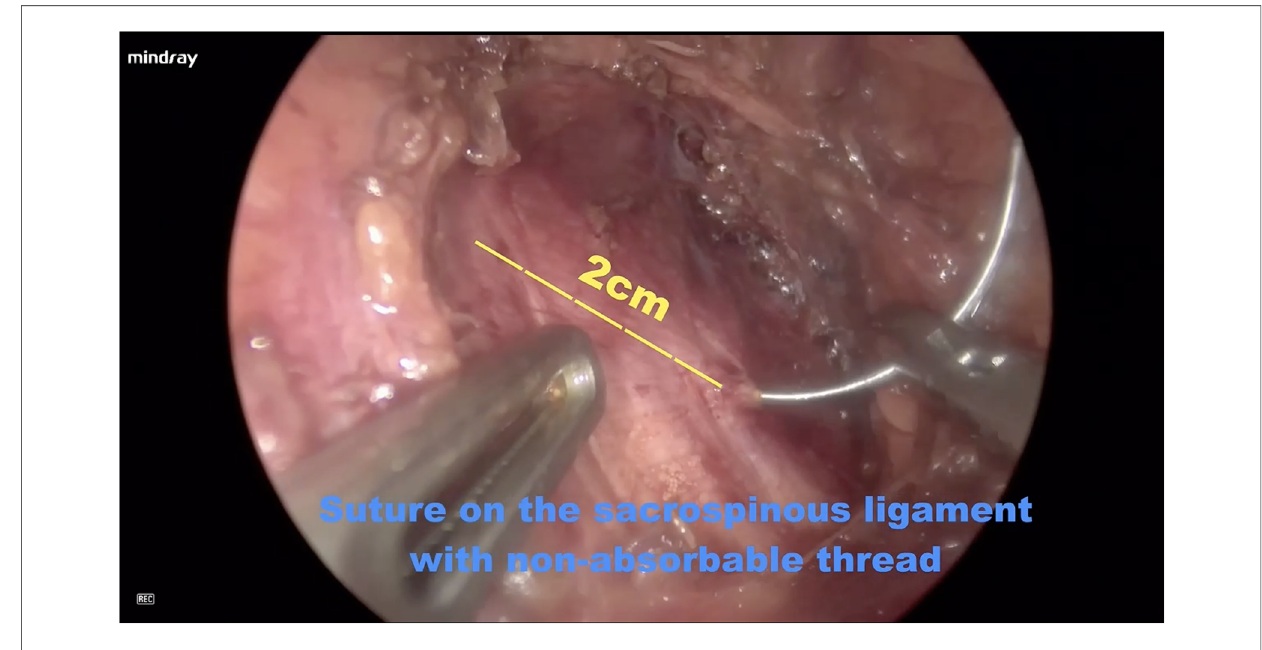
FIGURE 3 Sacrospinous ligament suturing. The right sacrospinous ligament was sutured with a nonabsorbable suture using a circular needle (O1/2 10×20) approximately 2 cm from the ischial spine at a depth of ≤ 0.3